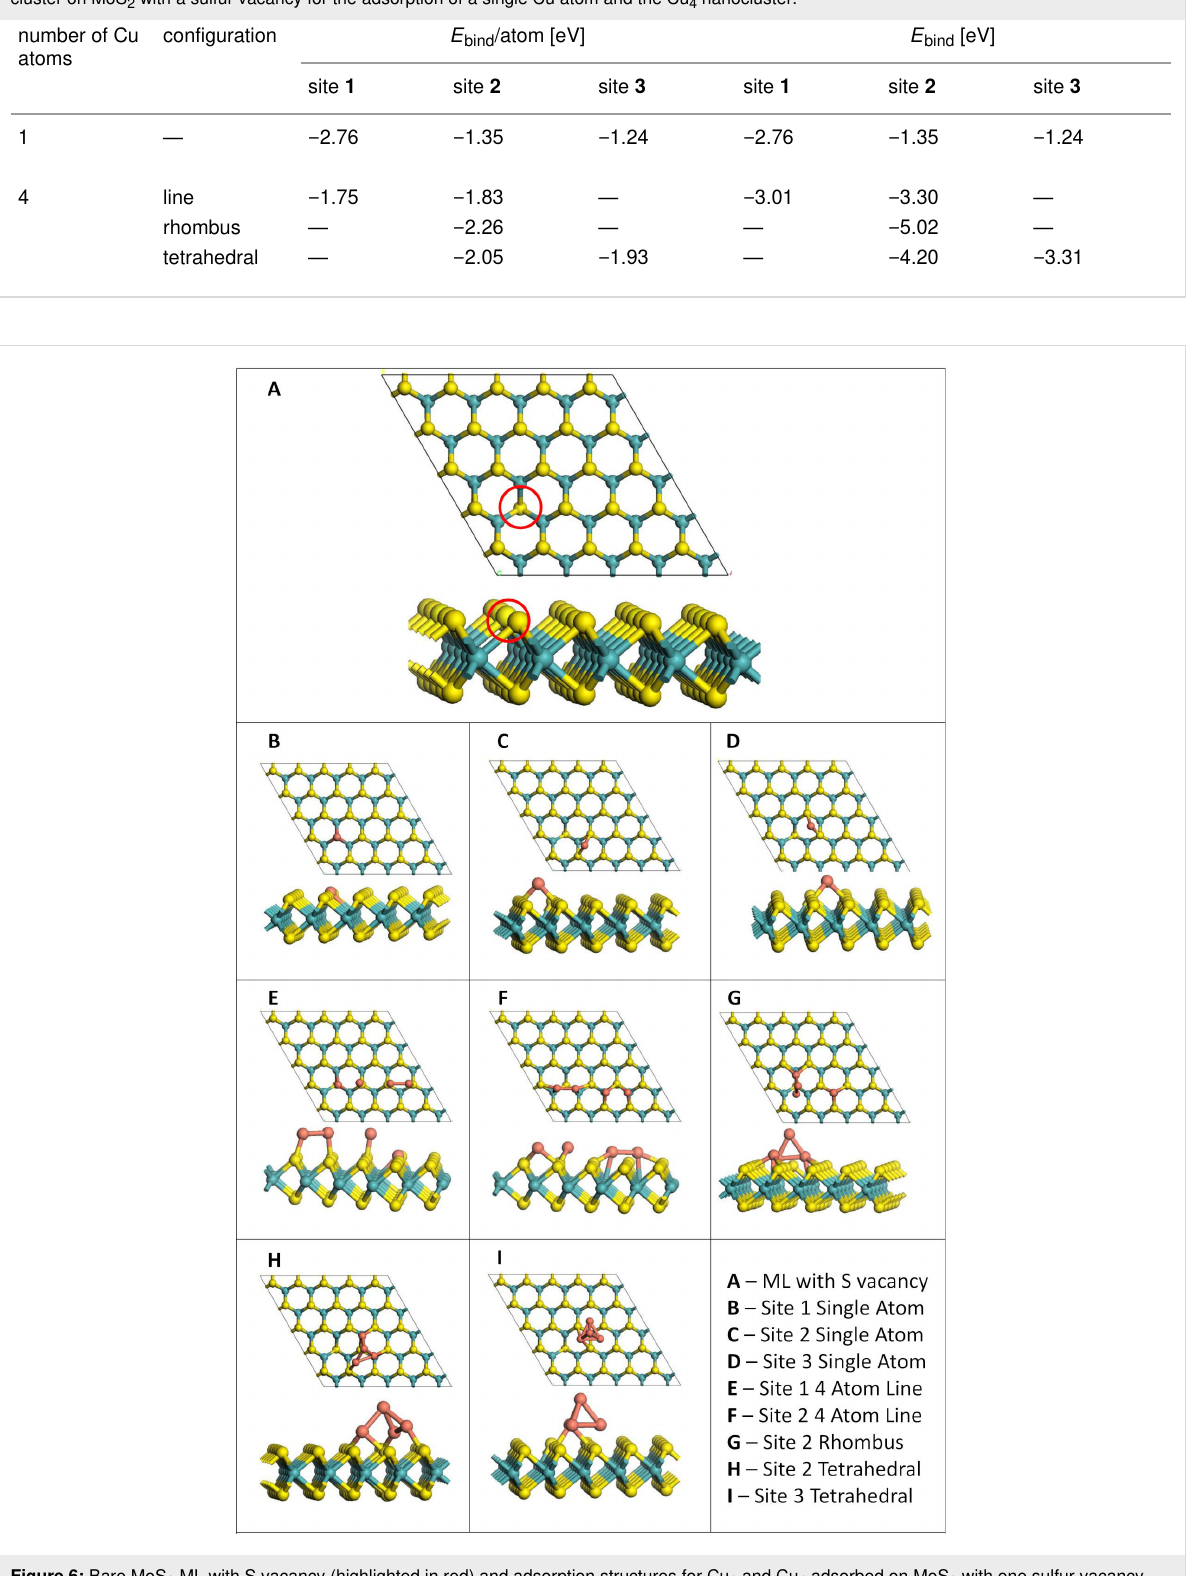
Figure 6: Bare MoS 2 ML with S vacancy (highlighted in red) and adsorption structures for Cu 1 and Cu 4 adsorbed on MoS 2 with one sulfur